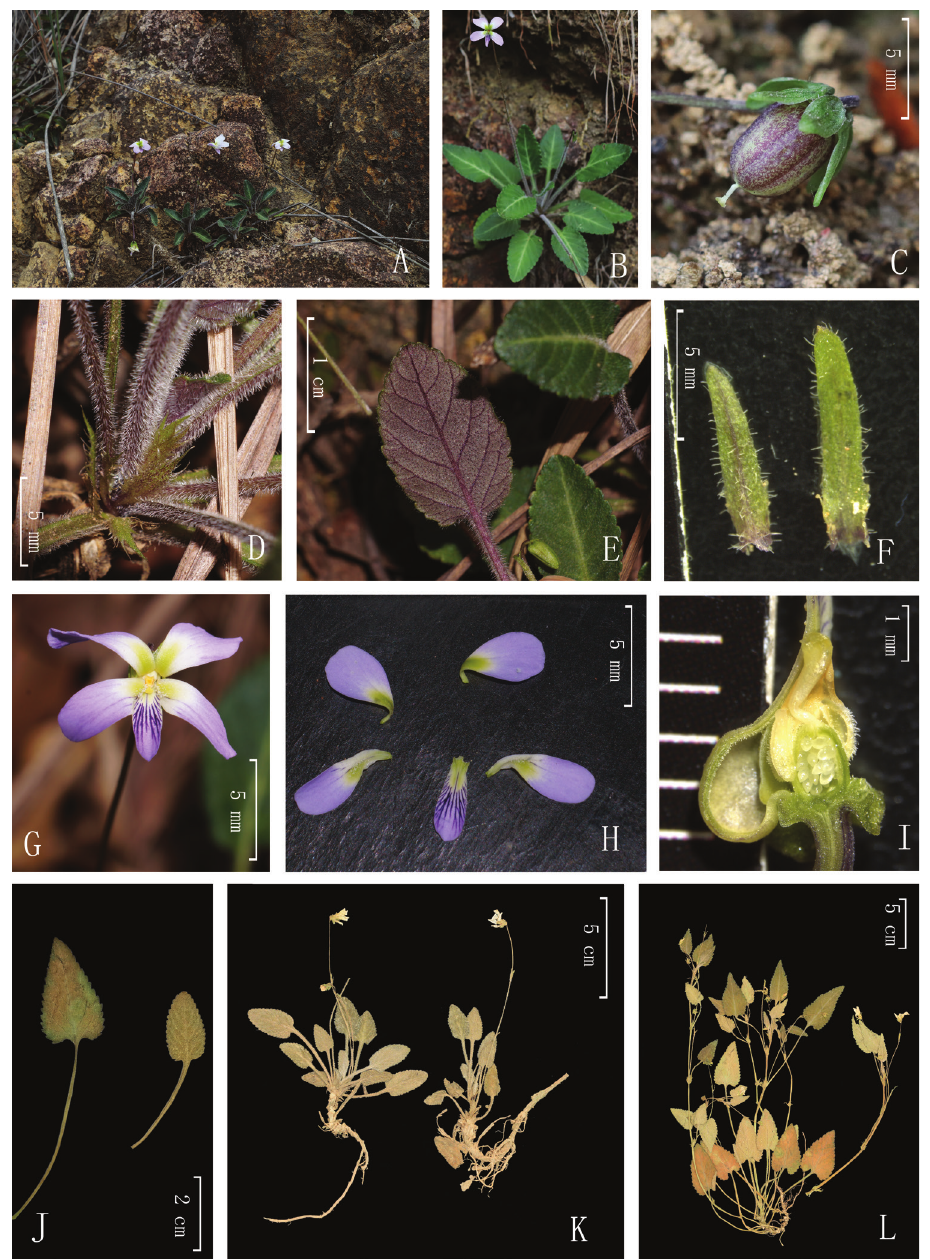
Figure 2. Viola huizhouensis A habitat B habit C young capsule with sepals and bracteoles D stem with stipules E abaxial surface of leaf blade F bracteoles G flowers H petals I longitudinal section of stigma and ovary J comparison of leaf blades. Left, V. guangzhouensis . Right, V. huizhouensis. K. Specimen of V. hu- izhouensis ( Y.S. Huang and Q. Fan 1803 ) . L. Specimen of V. guangzhouensis ( Y.S. Huang 1804